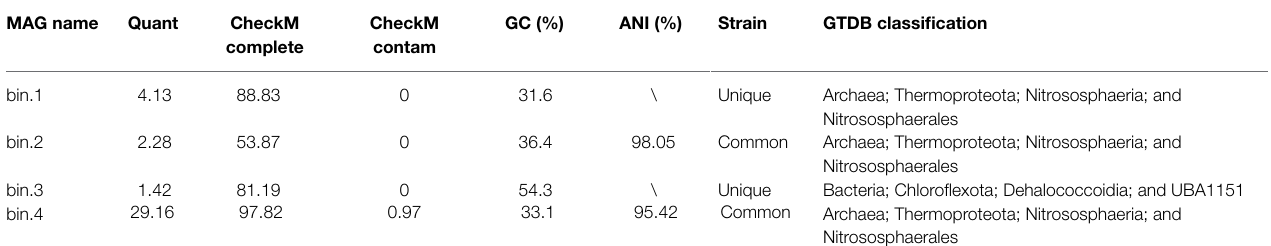
TABLE 1 | Metagenome-assembled genome properties and